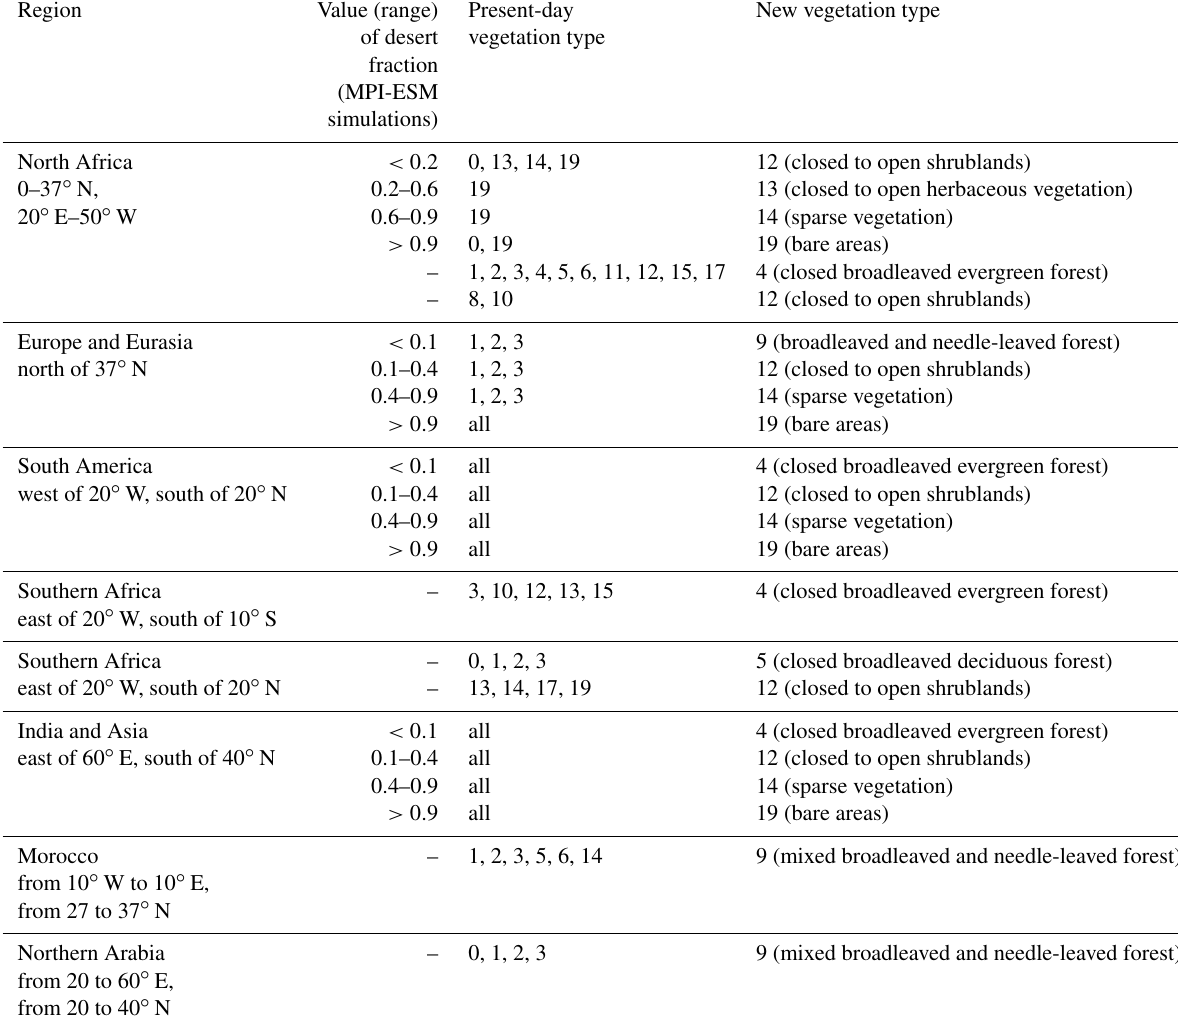
Table A1. Conditions for the prescription of the new vegetation types for the Green Sahara simulations. We prescribe a new, idealized vegetation cover that reflects mid-Holocene conditions depending on (1) the region, (2) the value range of the simulated desert fraction from the MPI-ESM Holocene simulations (Dallmeyer et al., 2020), and (3) the present-day vegetation type set as a default value in the forecast model of the Deutsche Wetterdienst (German Meteorological Service). Which numbers correspond to which vegetation type can be obtained from the legend of Fig.